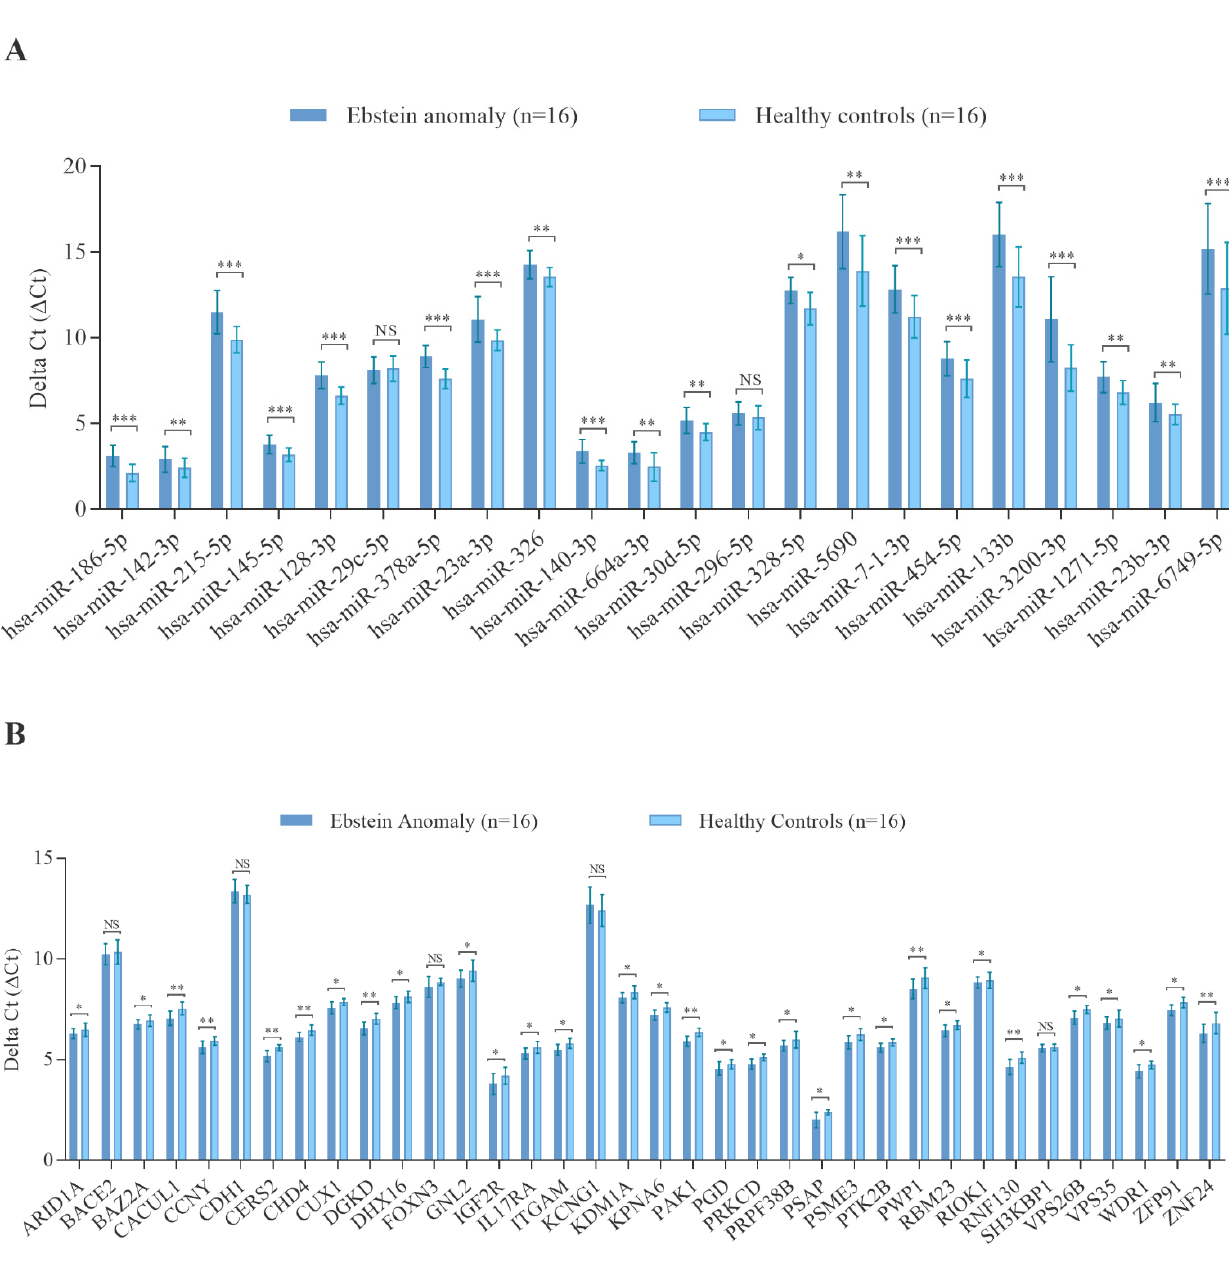
Figure 3. Validated miRNAs and target mRNAs in the blood of patients with Ebstein’s anomaly compared to healthy controls as determined by RT-qPCR. ( A ) Differentially abundant miRNAs, ( B ) differentially abundant mRNAs. Median ∆ Ct of all Ebstein’s anomaly and ∆ Ct of all healthy controls (lower ∆ Ct, higher abundance level). RNAU6B and GAPDH were used as endogenous controls for normalization for miRNA and mRNA, respectively. Un-paired-two-tailed t -tests and mean ± standard deviation (STDV) were used to evaluate differences in abundance levels. * p ≤ 0.05; ** p ≤ 0.01; *** p ≤ 0.001.